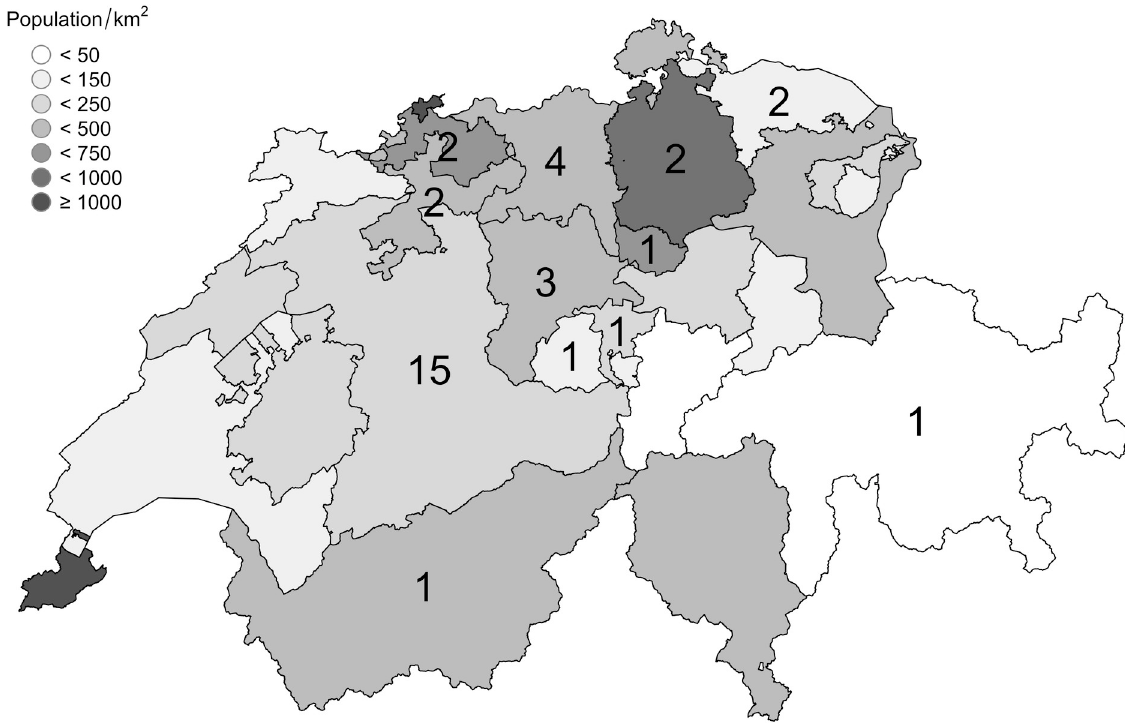
Fig 1. TAK patients in Switzerland. Displayed are Swiss cantons and their populations per km 2 . The number of patients (in black) are displayed per canton.